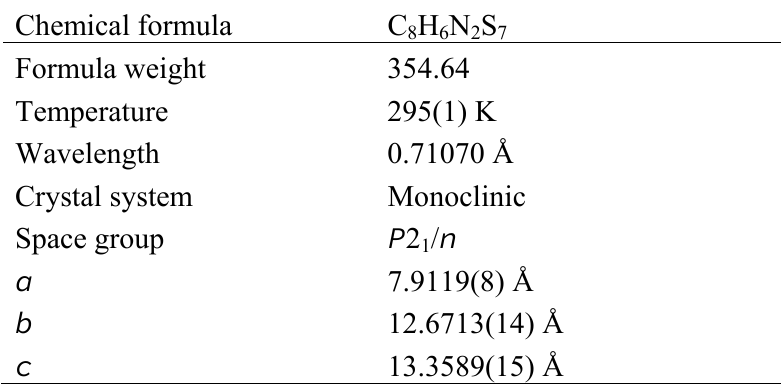
Table 2. Crystal data and refinement details for 1